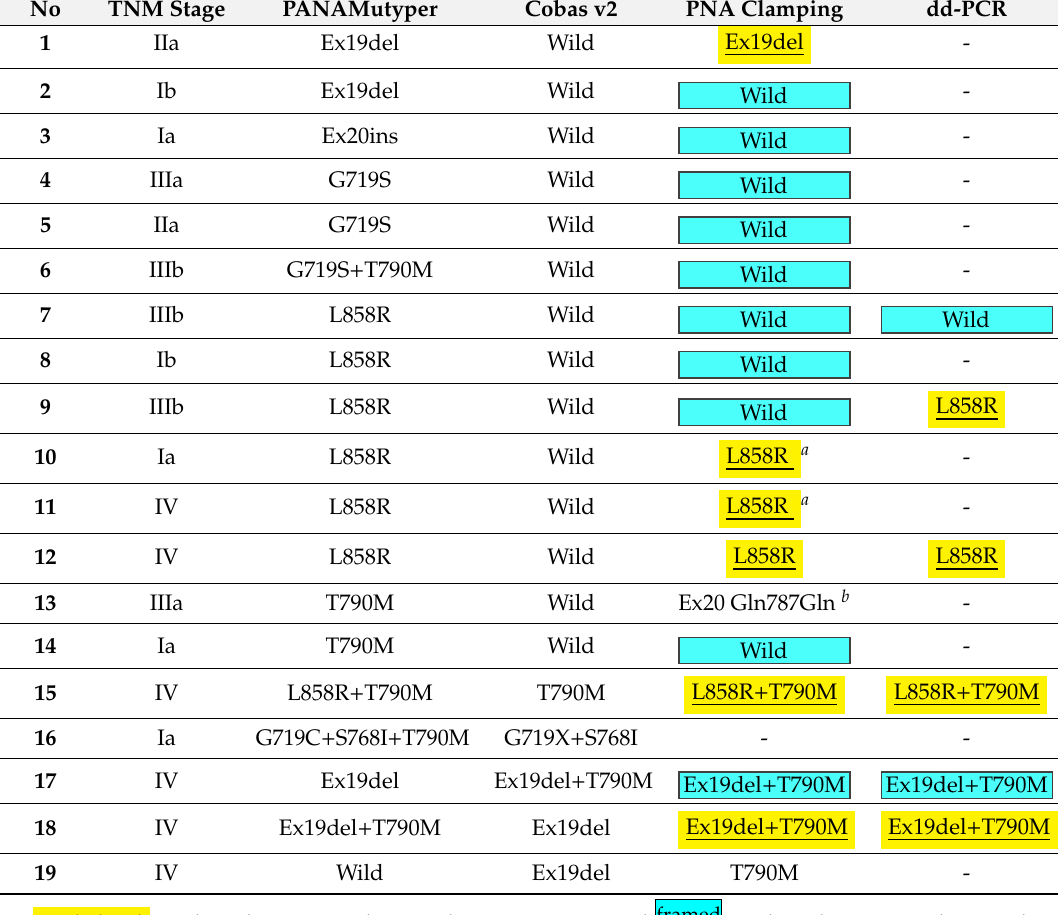
Table 3. Reanalysis of discordance between PANAMutyper and cobas v2